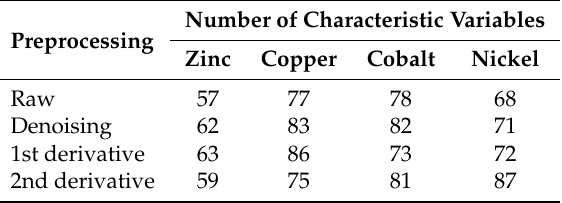
Figure 6. Characteristic variable selection and feature importance (VI) score results of zinc, copper, cobalt, and nickel ions in the original ( a ), denoising ( b ), first-order ( c ), and second-order derivative ( d ) spectra. The gray curves in each subplot are the spectra of the training set (Figure 6). Table 3. The number of selected characteristic variables by XGBoost of zinc, copper, cobalt, and nickel ions under different preprocessing